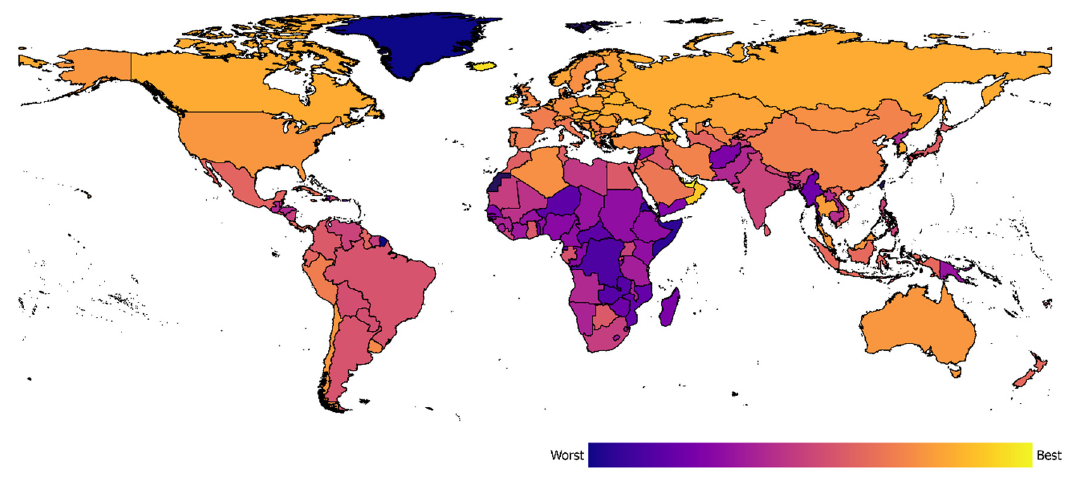
Figure 12. Global view on the culture dimension.